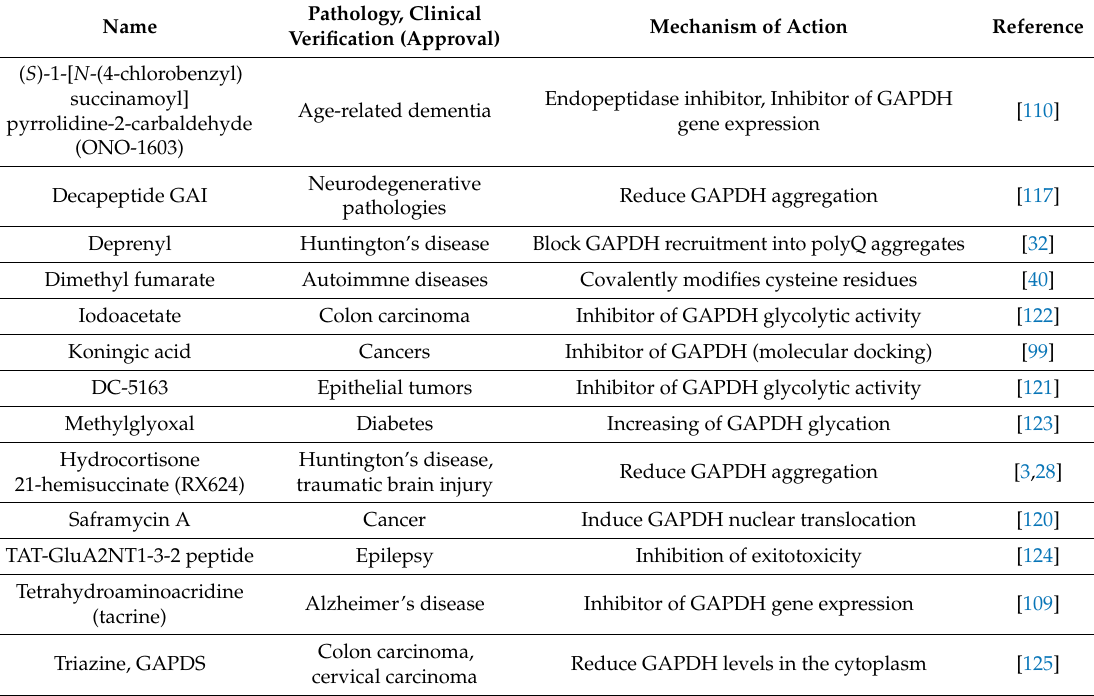
Table 2. GAPDH-targeted therapeutic